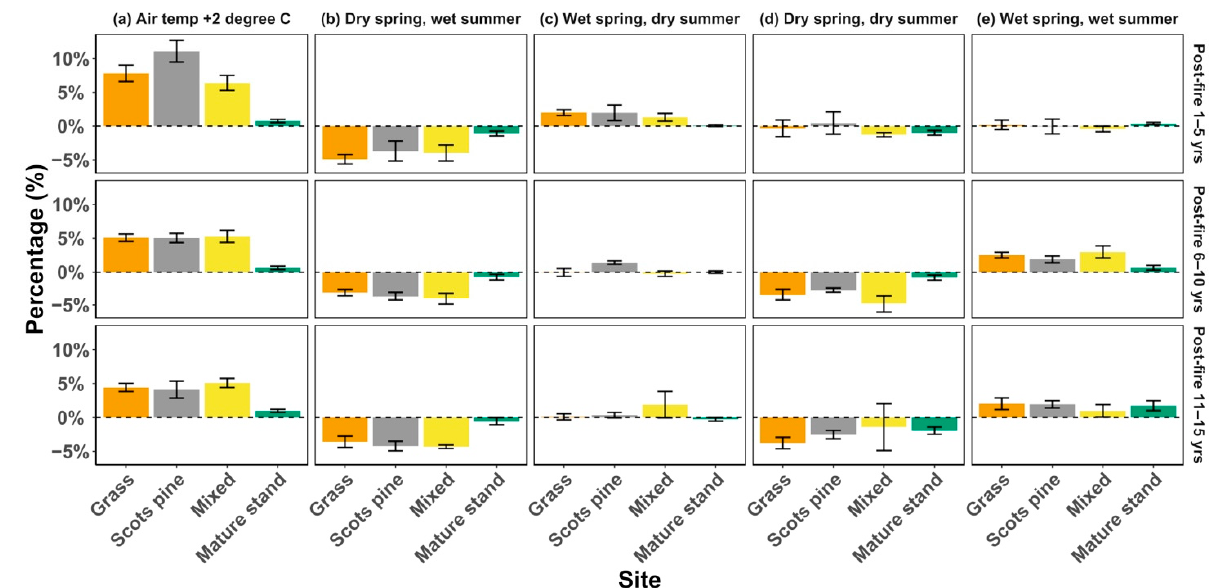
Figure 8. Relative changes of simulated NDVI (mean ± standard error) under ( a ) increased (by 2 ◦ C) monthly air temperature with average precipitation, ( b ) a 60% reduction in spring precipitation, whilst the annual total remained the same (dry spring, wet summer), ( c ) a 60% increase in spring precipitation, whilst the annual total remained the same (wet spring, dry summer), ( d ) 30% reductions in both spring and summer precipitation (dry spring, dry summer) and ( e ) 30% increases in both spring and summer precipitation (wet spring, wet summer) in grass-dominated, regenerating Scots pine, mixed and mature Scots pine stands.